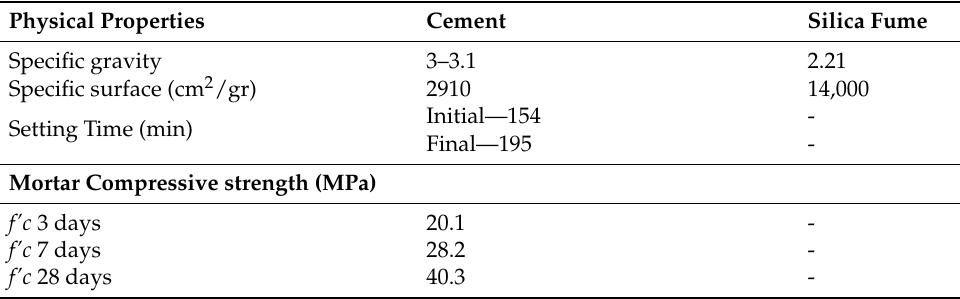
Table 2. Physical and mechanical properties of cement and silica